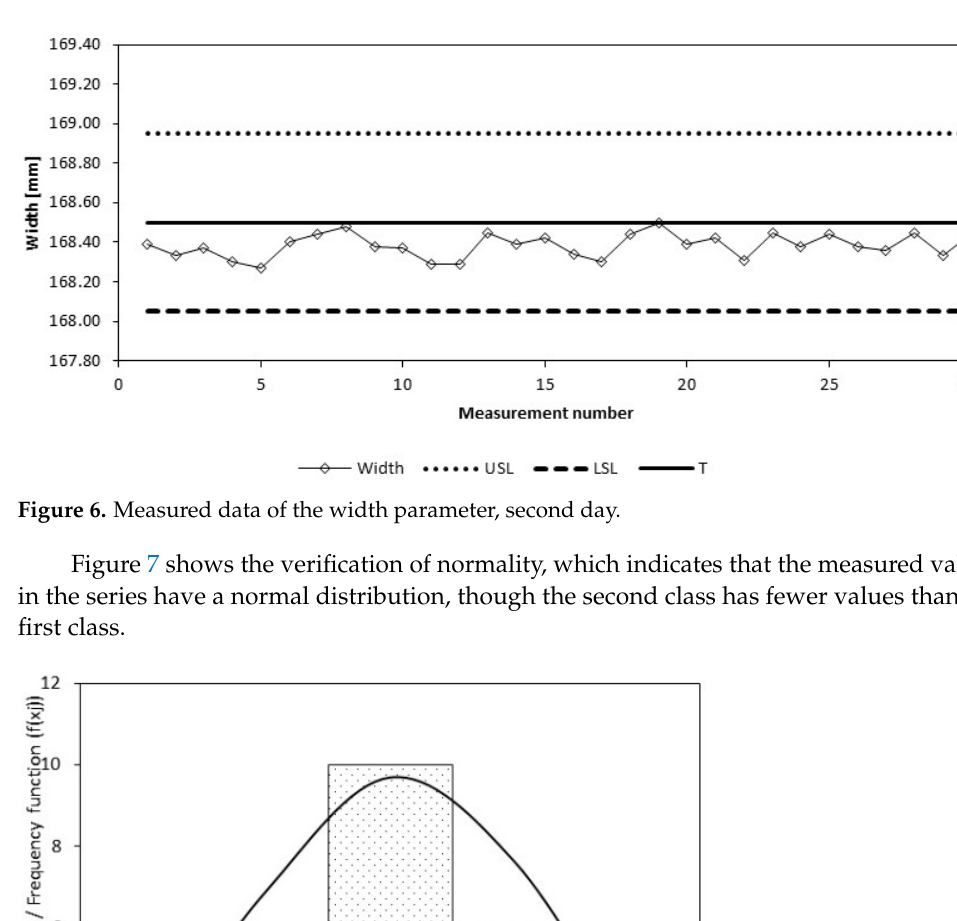
Figure 6. Measured data of the width parameter, 2 nd day.